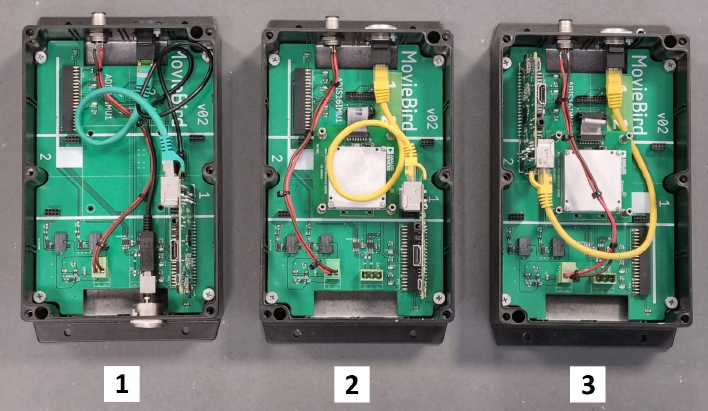
Figure 3. Core modules of the developed stabilization system: 1—server element, 2—accelerometer element, 3—main gyroscope sensor element [Source: MovieBird